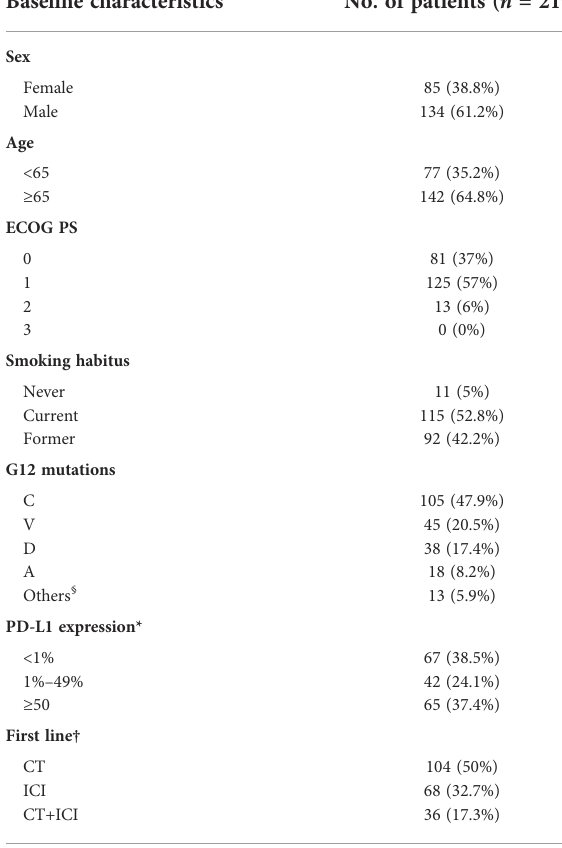
TABLE 1 Clinical and demographic patients characteristics. Baseline